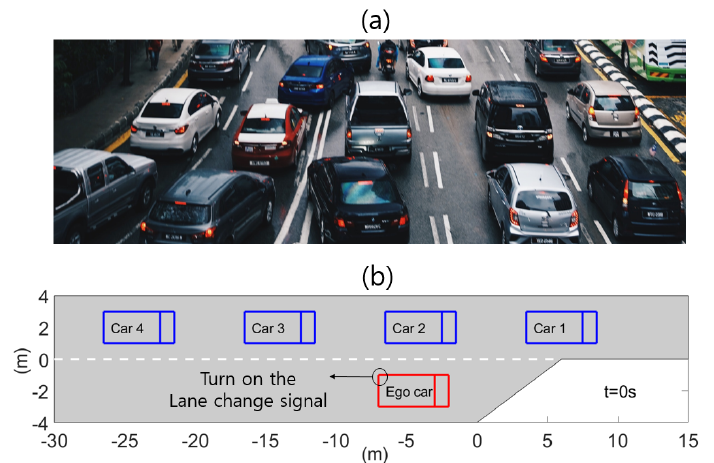
Figure 1. ( a ) Lane-merging scenario in the heavy traffic (photo is from Unsplash) and ( b ) reproducing the real-world driving